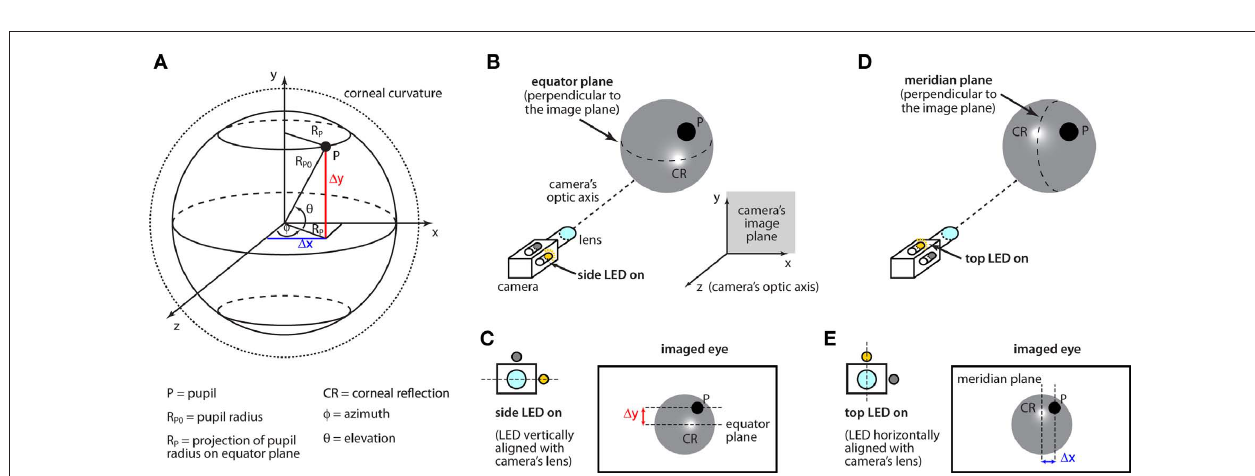
Figure 3 | eye coordinate system and measurements. (A) The pupil ( P ) moves to the image plane and horizontally bisects the eye), and the distance ∆ x of the over the surface of a sphere (solid circle) of radius R . Such a sphere is contained pupil’s projection on the equator plane from the meridian plane (i.e., the plane that P 0 within a larger sphere – the extension of the corneal curvature (dotted line). The two is perpendicular to the image plane and vertically bisects the eye). (B) In our spheres are assumed to have the same center (see text). The pupil position is imaging system, two infrared LEDs flank the imaging camera. When the side LED measured in a polar coordinate system, whose origin is in the center of the corneal (which is vertically aligned with the camera’s lens) is turned on, its reflection on the curvature. The orientation of the reference system is chosen such that the z axis is corneal surface ( CR ) marks the position of the equator plane. (C) ∆ y is measured as parallel to the optic axis of the camera and, therefore, the ( x , y ) plane constitutes the distance between P and CR , when the side LED is turned on. (D) When the top the camera’s image plane (see inset in B ). The goal of the eye-tracking system is to LED (which is horizontally aligned with the camera’s lens) is turned on, its reflection estimate the pupil’s elevation ( θ ) and azimuth ( φ ). This is achieved by measuring the on the corneal surface ( CR ) marks the position of the meridian plane. (e) ∆ x is distance ∆ y of the pupil from the equator plane (i.e., the plane that is perpendicular measured as the distance between P and CR , when the top LED is turned on.